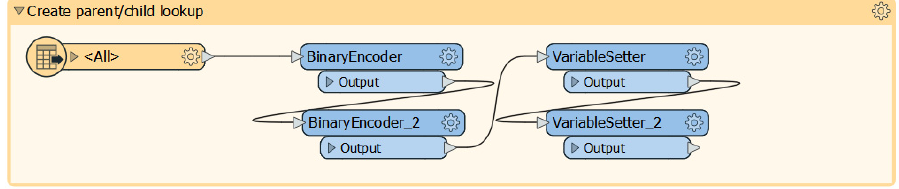
Figure 13. Create parent/child lookup.